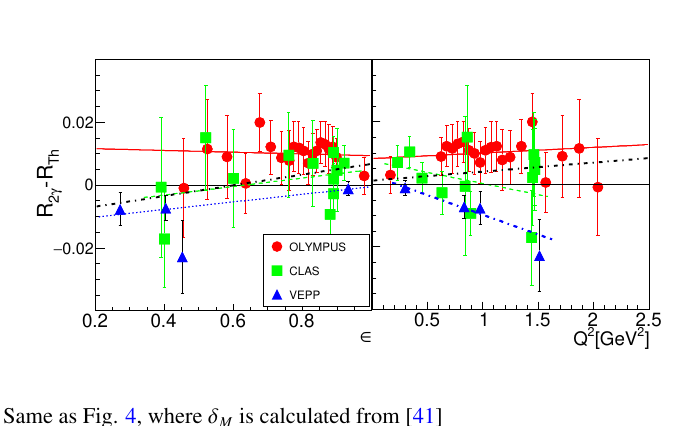
Figure 4. Same as Fig. 4, where δ M is calculated from